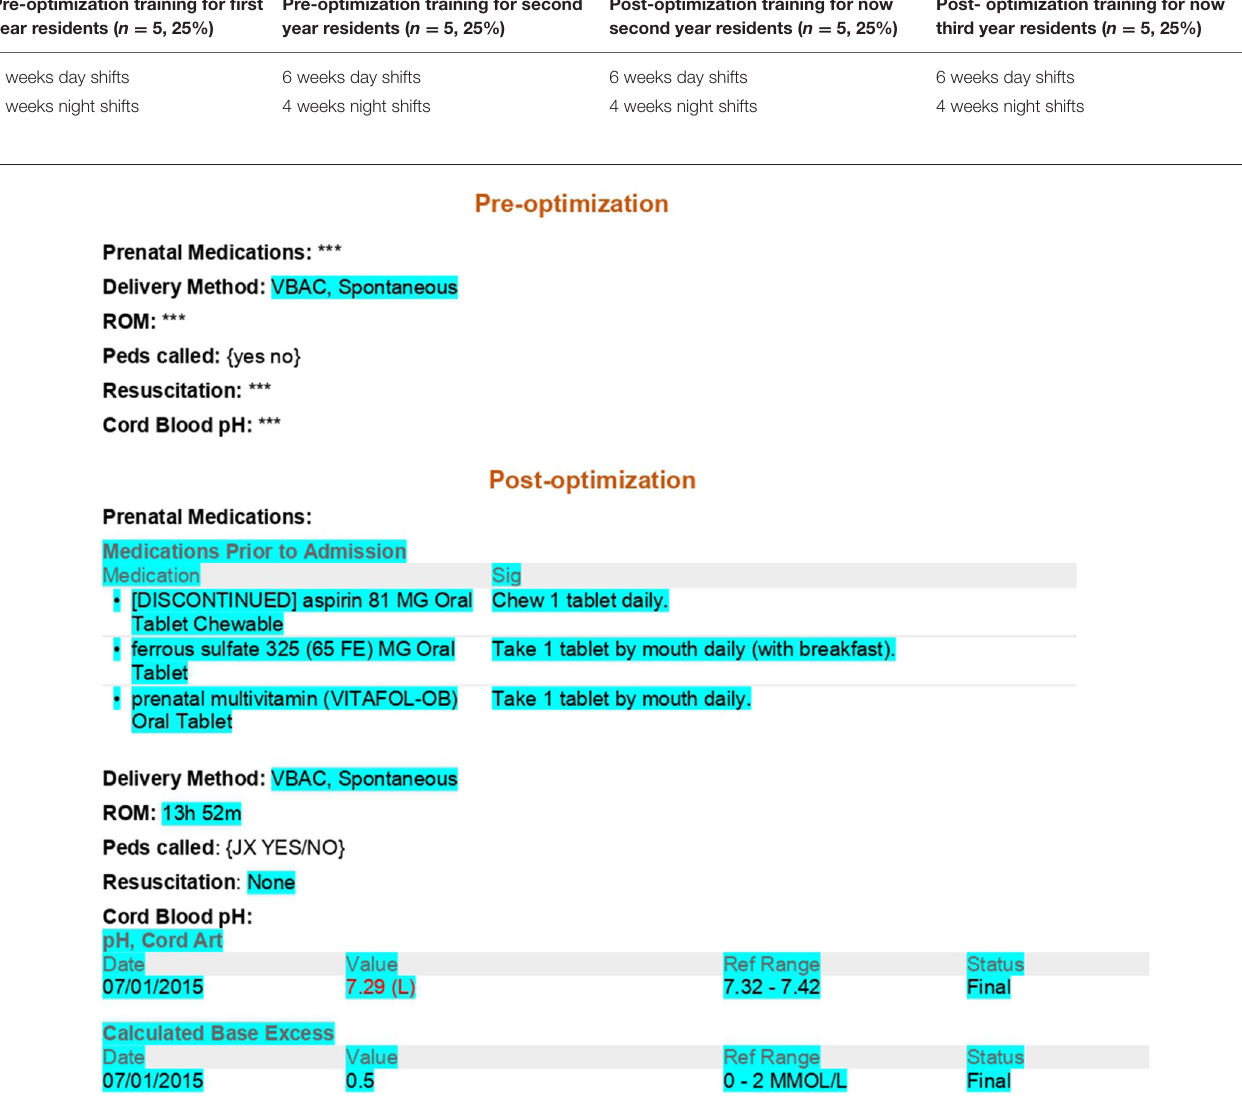
FIGURE 1 | Maternal information comparison pre and post note optimization blue highlight: Auto generated data. ***: Manual entry of data required. {}: Pick list. Epic codes are omitted. VBAC, Vaginal birth after cesarean section; ROM, Rupture of membranes; Peds,